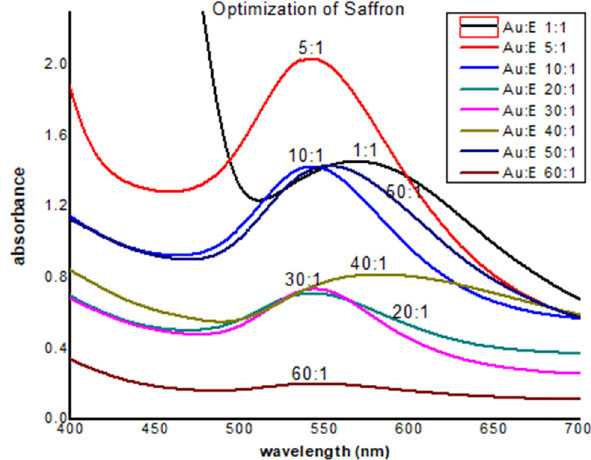
Figure 3: UV - Visible spectra of AuNPs of sa ff